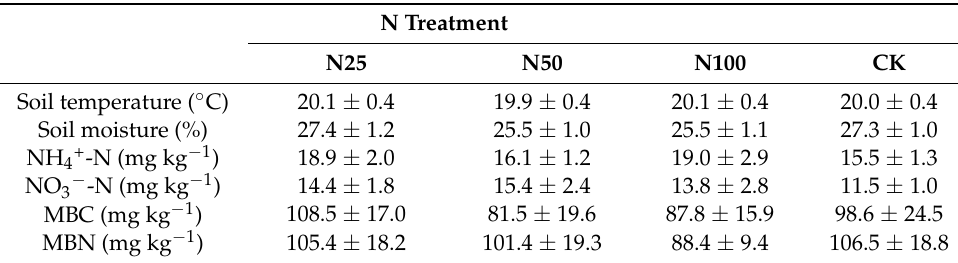
Table 1. Selected soil characteristics under different N treatments. N additions had no significant impacts on any variable shown.